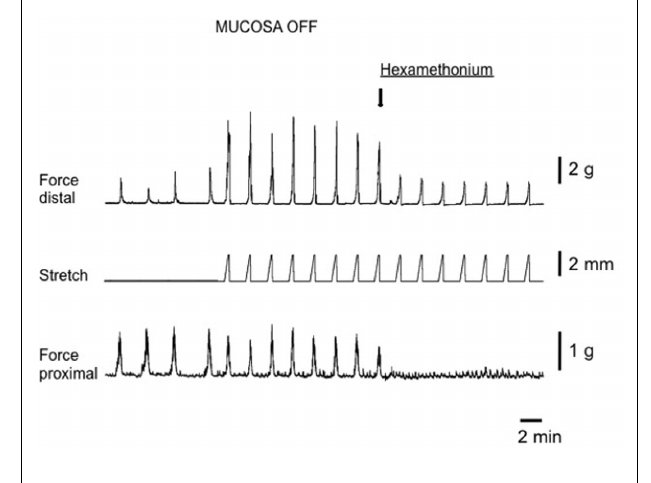
FIGURE 2 | Circumferential stretch-evoked CMMCs in isolated whole mouse colon devoid of mucosa and submucosal plexus. On the left side of the figure four spontaneous CMMCs occur prior to circumferential stretch applied. Circumferential stretch was applied to the distal colon (see stretch trace) and evoked CMMCs at an increased frequency than the spontaneous frequency.The amplitude of spontaneous and evoked CMMCs in the proximal colon was no different. Upon addition of Hexamethonium (300 μ M) stretch-evoked CMMCs were abolished in the proximal colon. During imposed stretches in the presence of hexamethonium a passive increase in tension occurs in the distal colon, but no CMMCs are evoked.